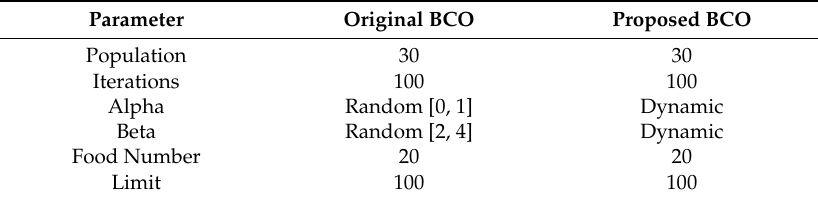
Table 7. Parameters for the BCO method